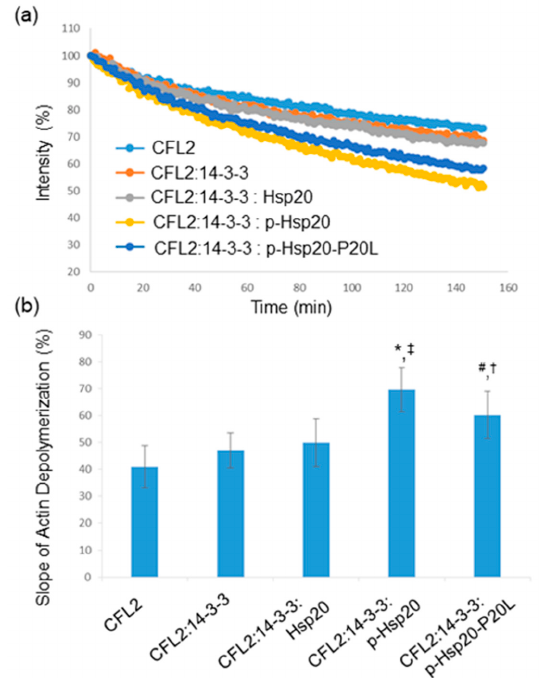
Figure 7. Hsp20 phosphorylation enhances CFL2 mediated actin depolymerization. ( a ) In